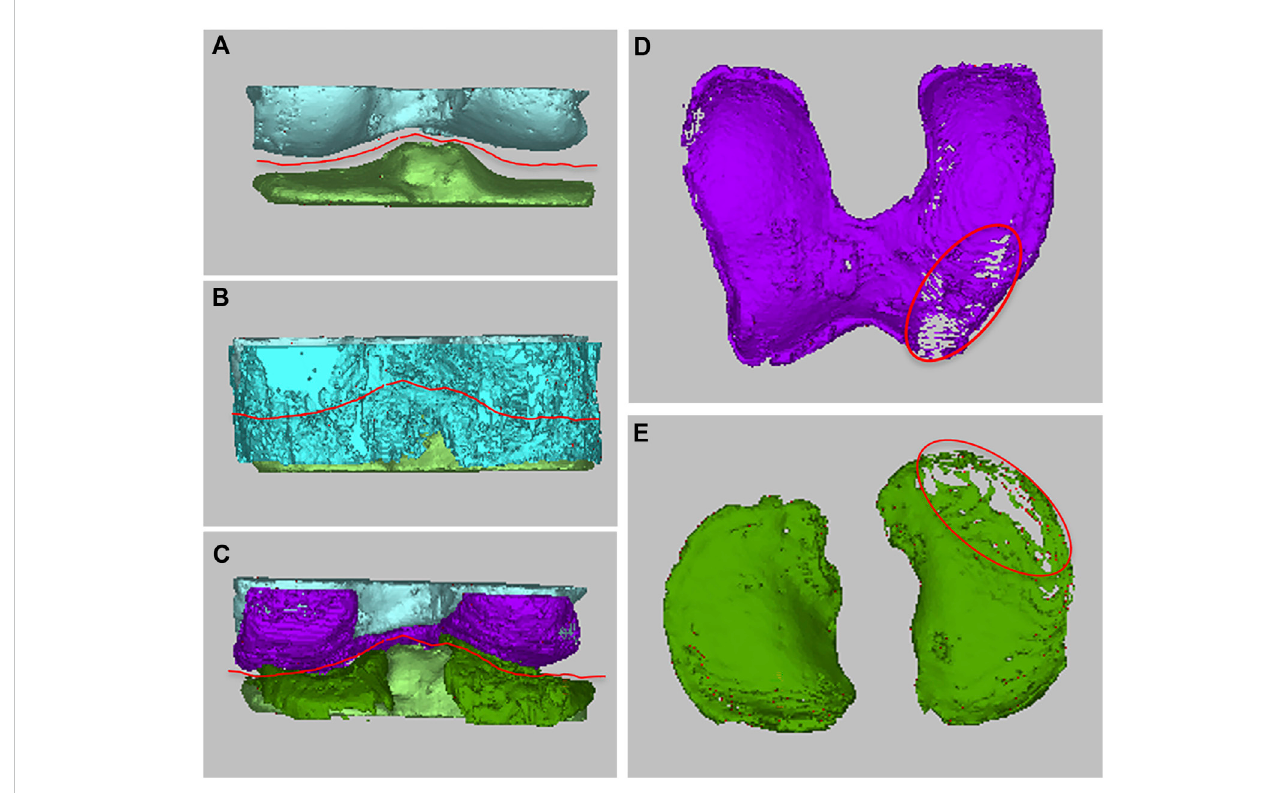
FIGURE 2 Qualitative analysisoffemoralcartilageandtibialcartilage. (A – C) The articular cartilage wasdeterminedwith thearticular surfaceof femurortibiaas the reference template, (D,E) the damage of cartilage were qualitatively analyzed based on the defect of articular